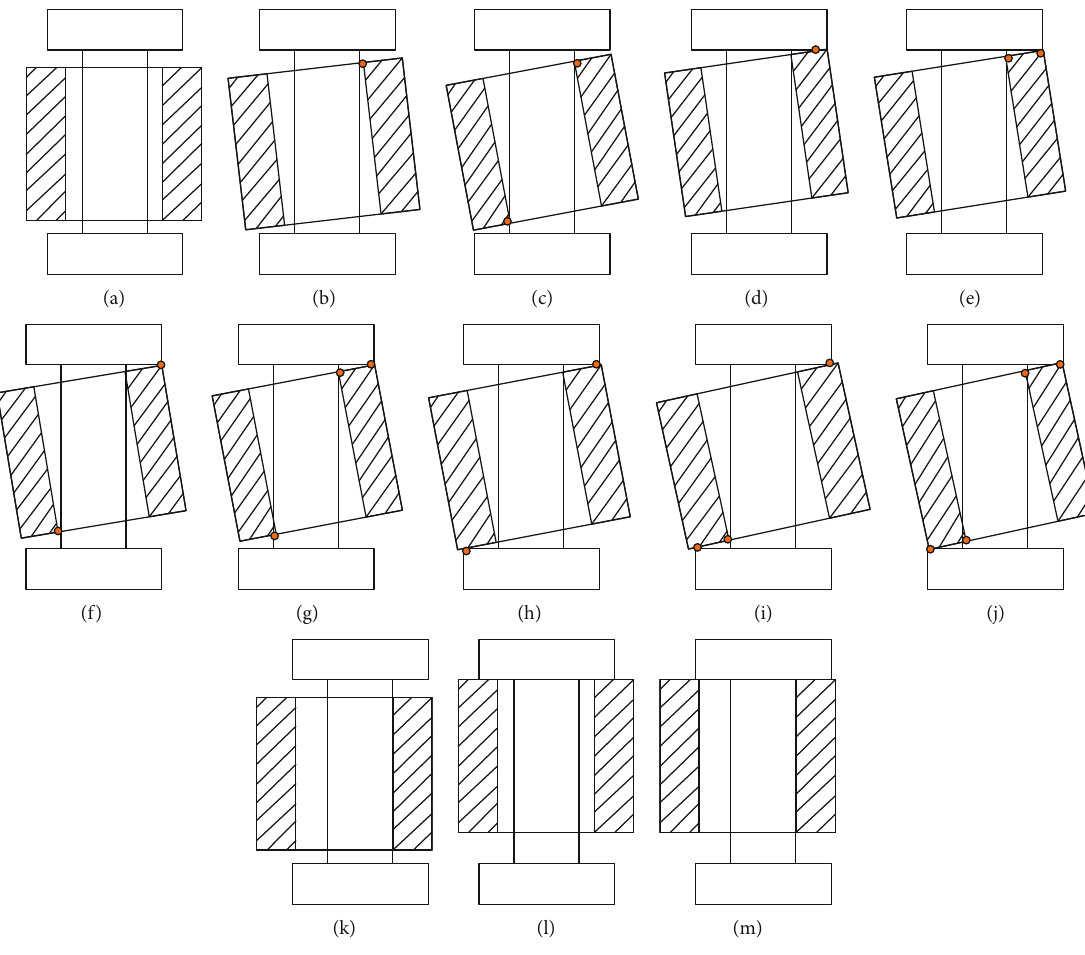
Figure 3: Contact scenarios of revolute joint with 3D